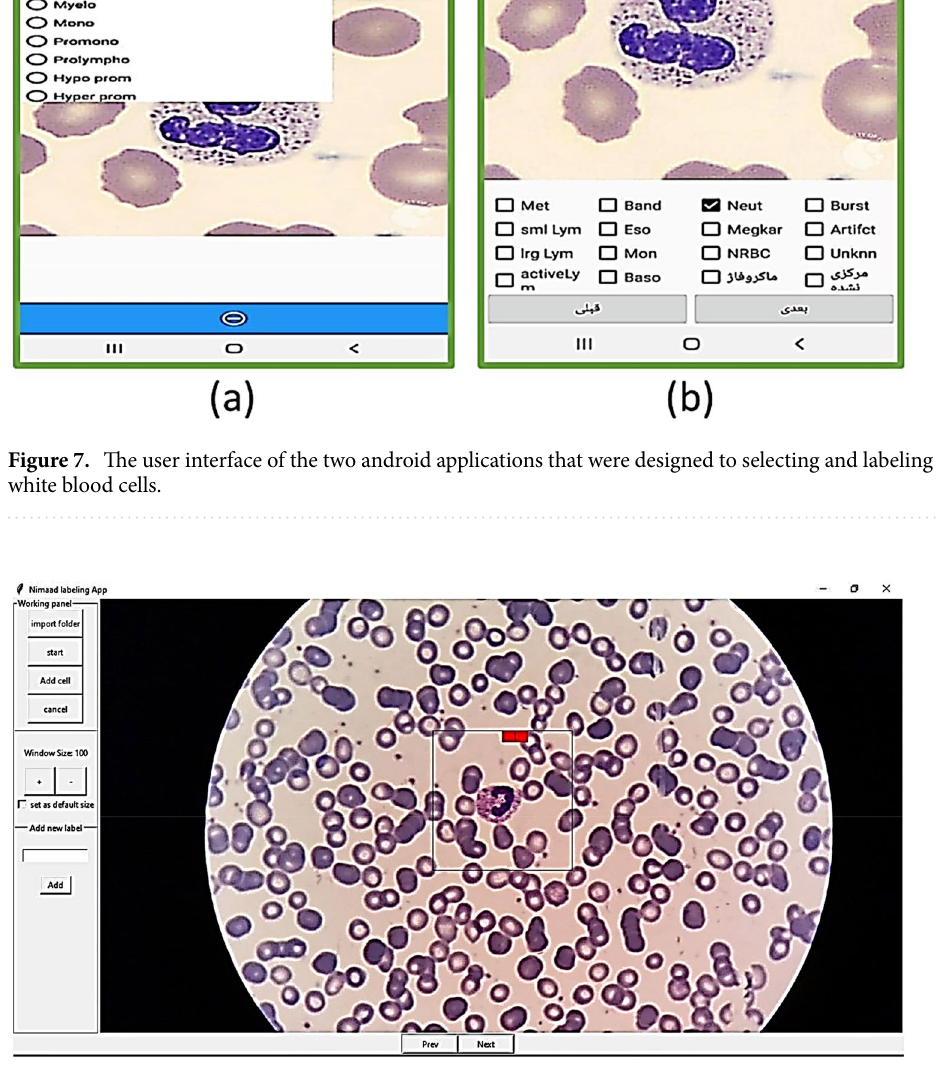
Figure 8. The user interface of the desktop application designed for labeling white blood